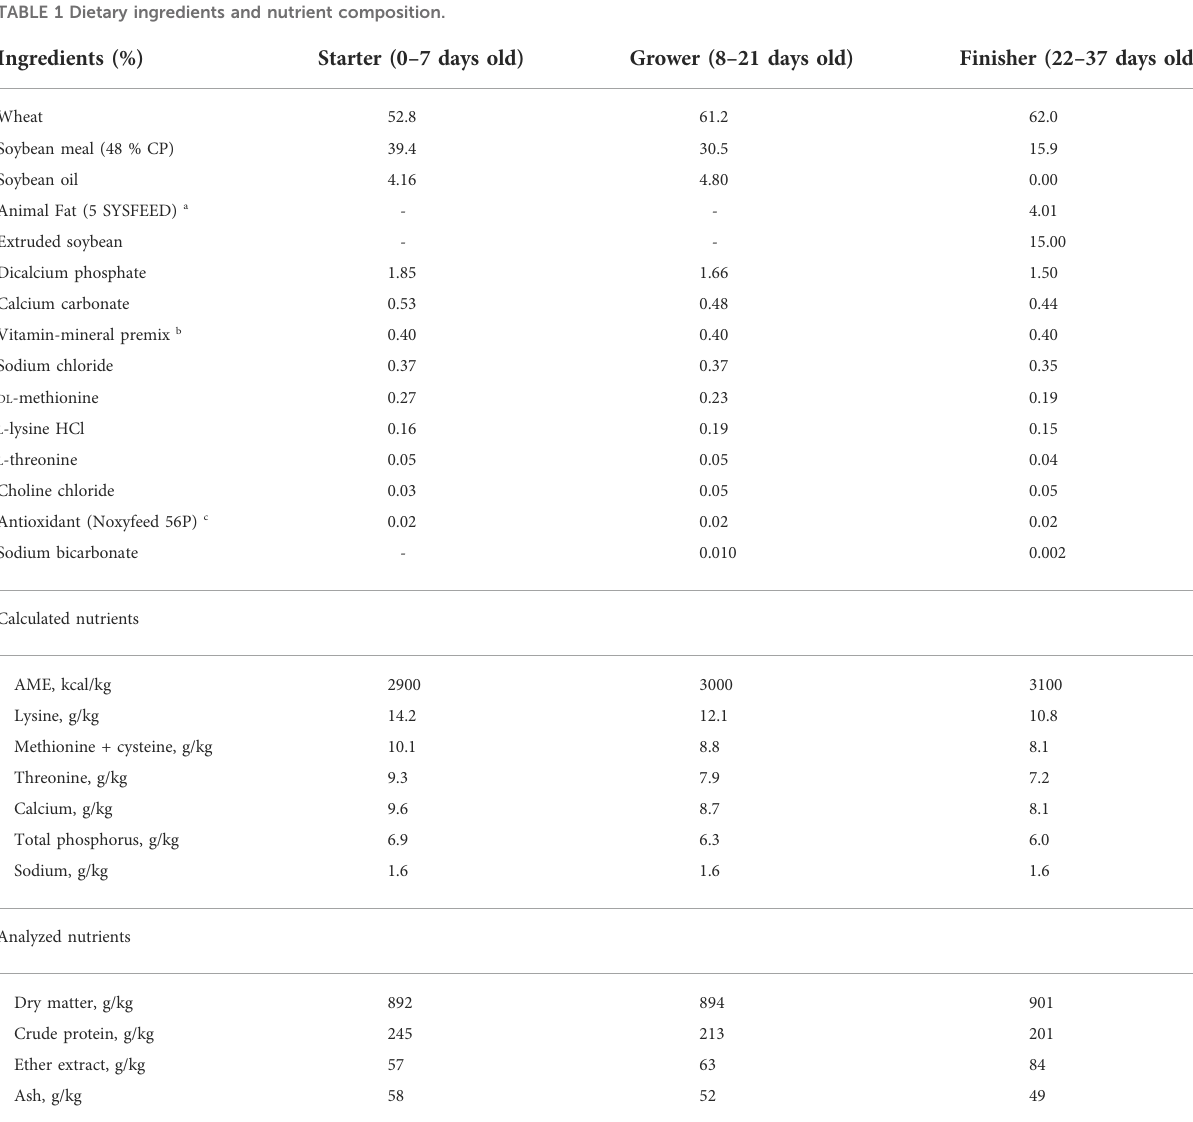
TABLE 1 Dietary ingredients and nutrient